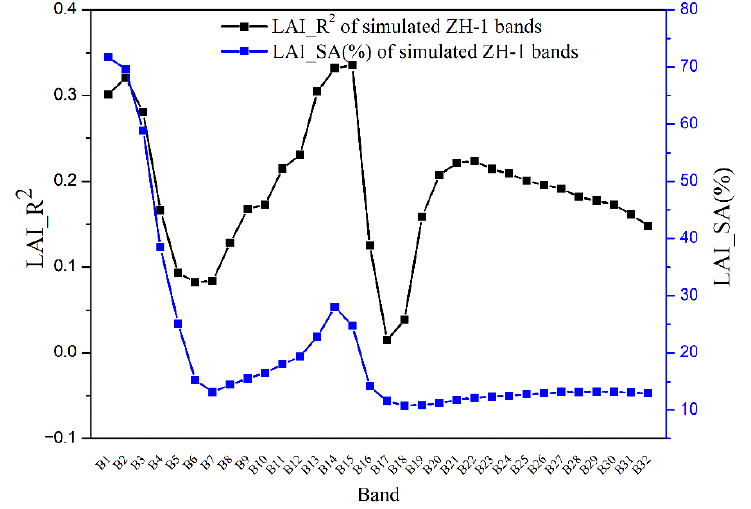
Figure 4. Single-band LAI estimation and sensitivity comparison.